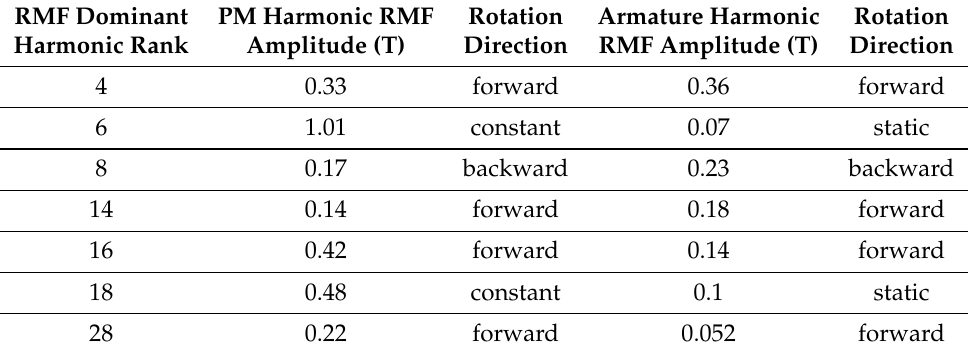
Table 2. RMF-dominant harmonics contributing to torque of the FSPMM under study. RMF Dominant PM Harmonic RMF Rotation Armature Harmonic Rotation Harmonic Rank Amplitude (T) Direction RMF Amplitude (T) Direction 4